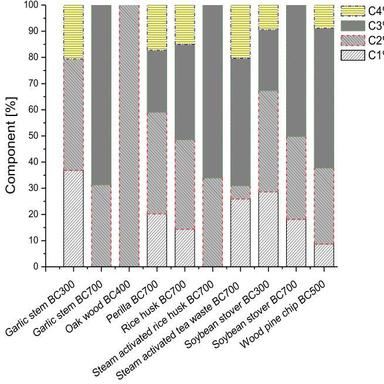
Distribution of PARAFAC components (C1: UVA humic-like component, C2: protein/tannin-like component, C3: fulvic acid-like component, C4: terrestrial humic-like component) of different biochar samples (GS 300: Garlic stem BC300, GS 700: Garlic stem BC700, OW400: oak wood BC400, PE 700: Perilla BC700, RH 700: Rice husk BC700, SA-RH 700: Steam activated rice husk BC700, SA-TW 700: Steam activated tea waste BC700, SS 300: Soybean stover BC300, SS 700: Soybean stover BC700, WP 500: Wood pine chip BC500).